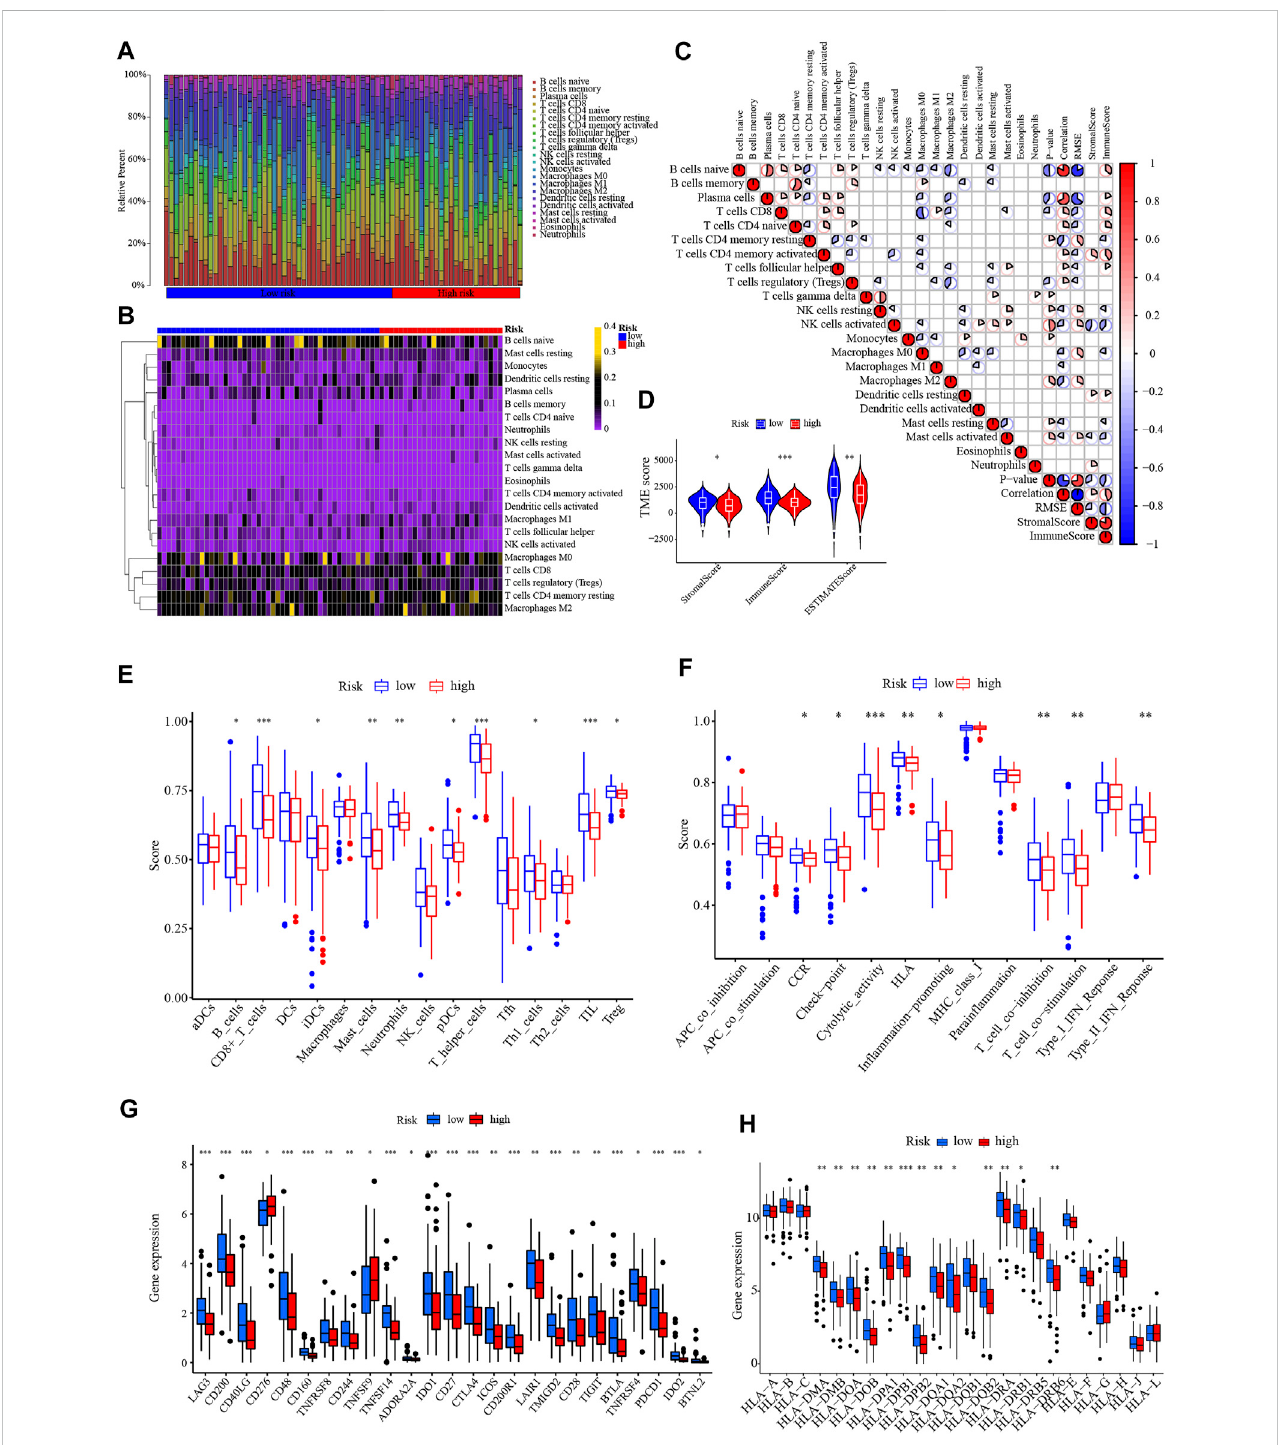
FIGURE 9 Immune in fi ltration analysis. (A,B) The bar chart and heatmap revealed the percentage of 22 in fi ltrating immune cells in the TCGA. (C) The correlation between in fi ltrating immune cells. (D) Comparison of the Stromal, Immune, and ESTIMATE scores between different risk groups. (E,F) The ssGSEA of the proportionofimmunecellsin fi ltrationandimmunefunctionindifferentriskgroups. (G) Thedifferentialexpressionofimmunecheckpointsbetweenlow-and high-risk groups. (H) The differential expression of HLA genes between different risk groups. * p < .05, ** p < .01; *** p < .001; ns, not signi fi